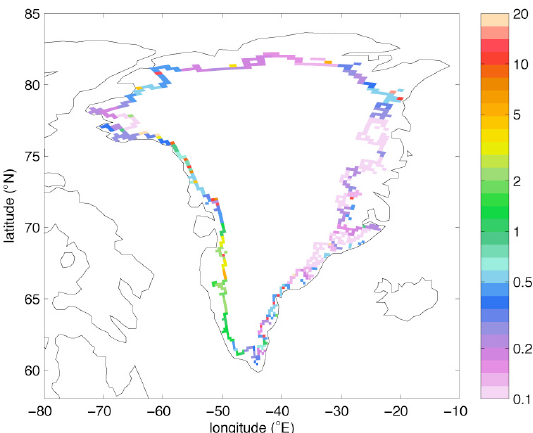
Fig. 4. Annual melt fluxes (km 3 ) predicted with an energy mass balance model of the Greenland Ice Sheet (averaged for 1991–99), as located on the ice sheet, prior to re-location to coastal gridcells of NEMO.